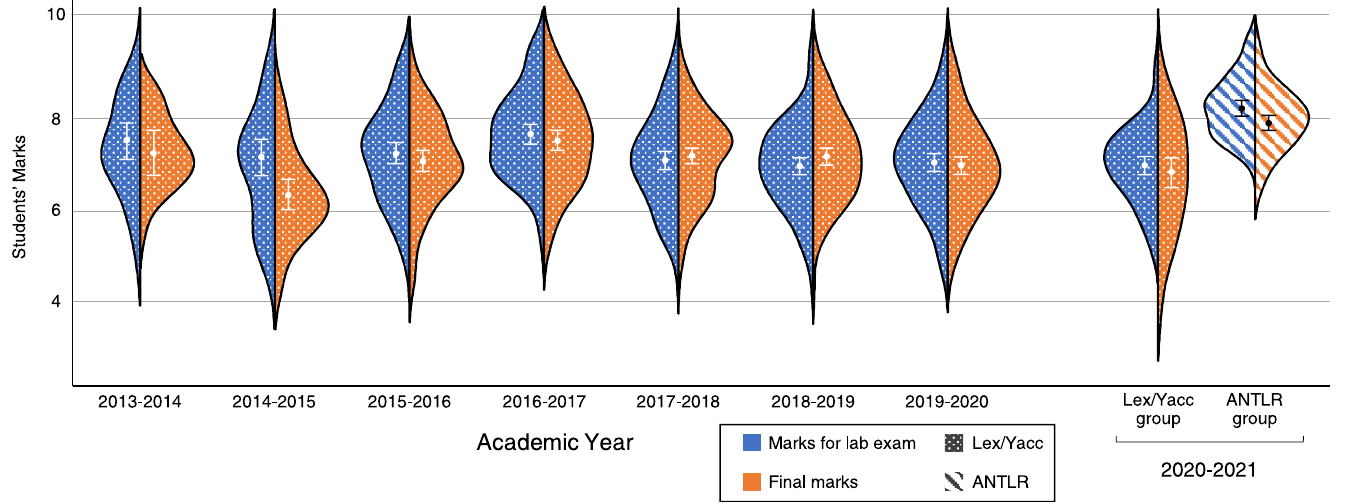
Fig 4. Final and lab marks of the last 8 academic courses. Whiskers represent 95% confidence intervals and the points denote their mean values.